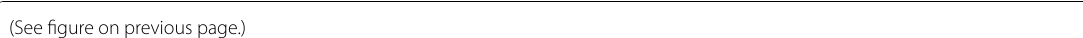
1.0 in the R3, R4, R5, and R8 ≥